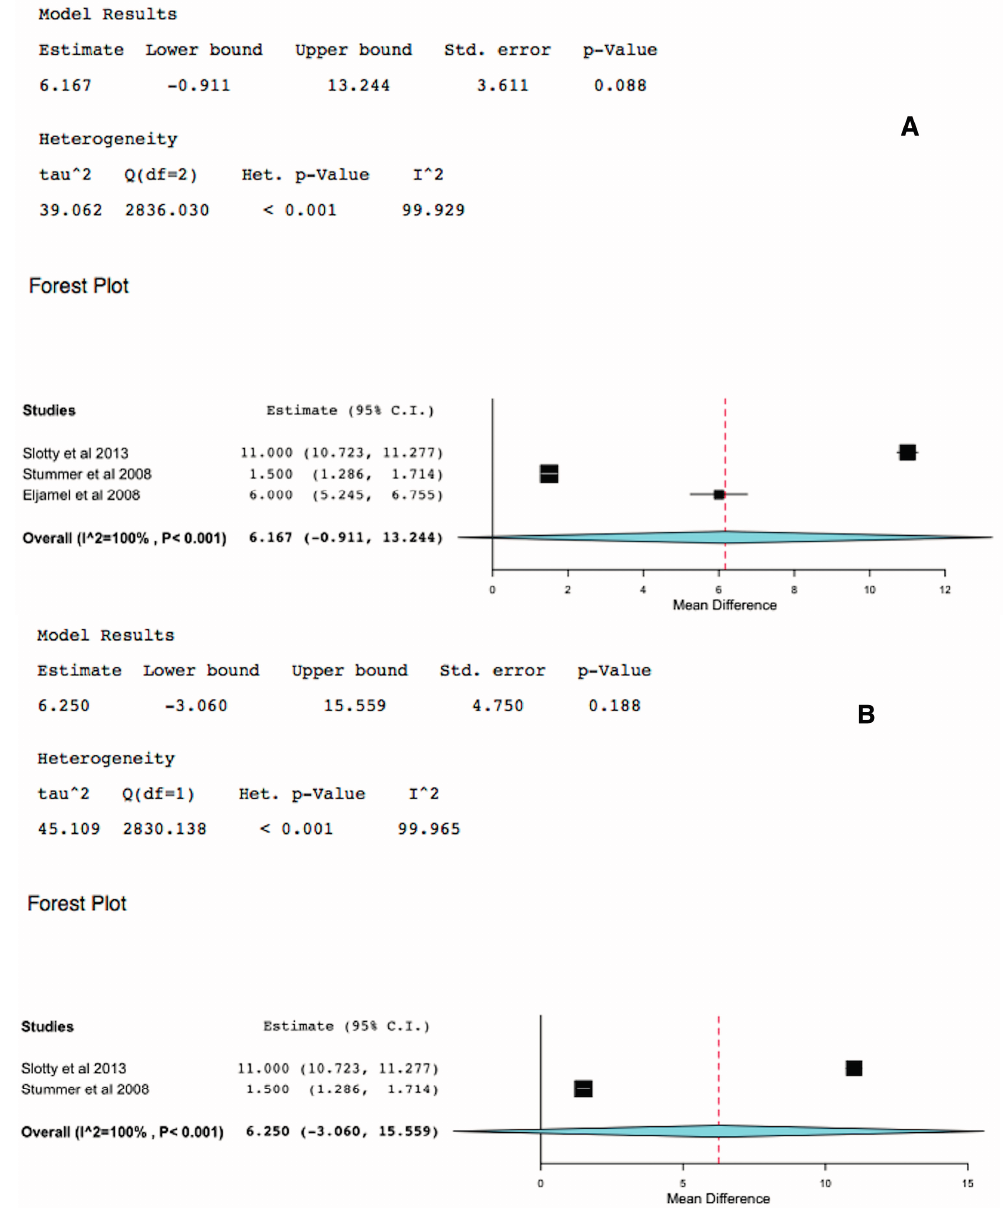
Figure 4. Forest plot (meta-analysis) and heterogeneity of 5-ALA-FIGR survival difference. ( A ) excludes study [15] and ( B ) includes it, because study [15] had rPDT in addition